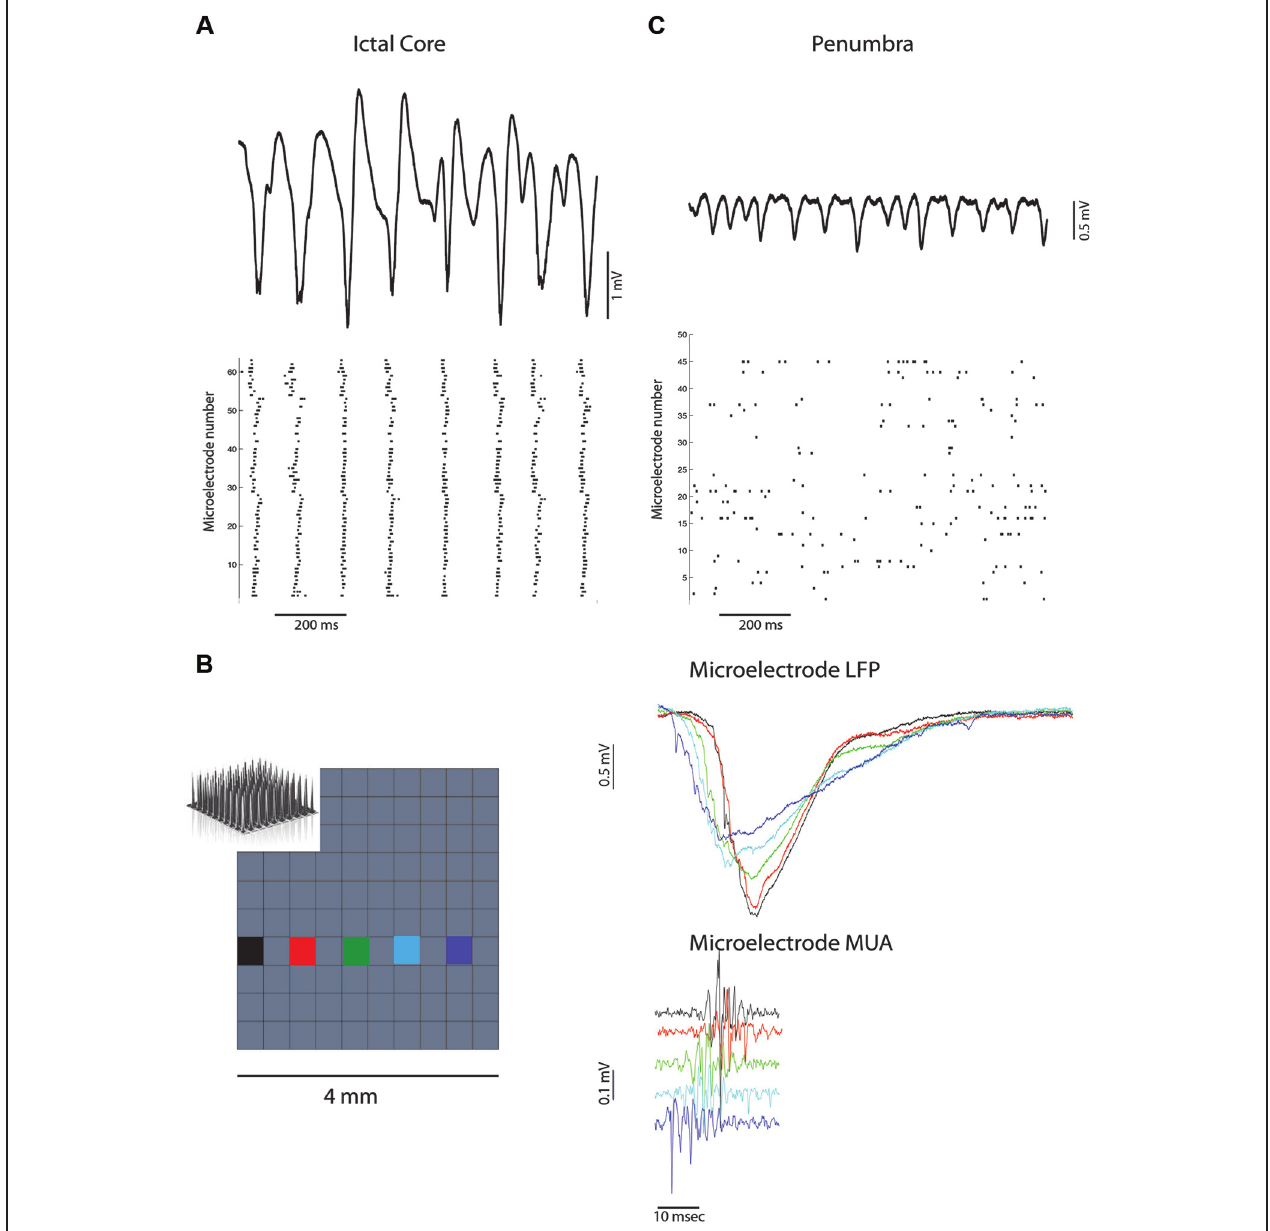
the multi-electrode array (left). Corresponding multi-unit activity reflects propagation and the lack of synchronization at the scale of 1 ms. (C) Broadband recording of ictal discharges from one of the microelectrodes in the array implanted in the penumbra (above). Corresponding raster plot of multi-unit action potentials illustrate heterogeneity and lack of global